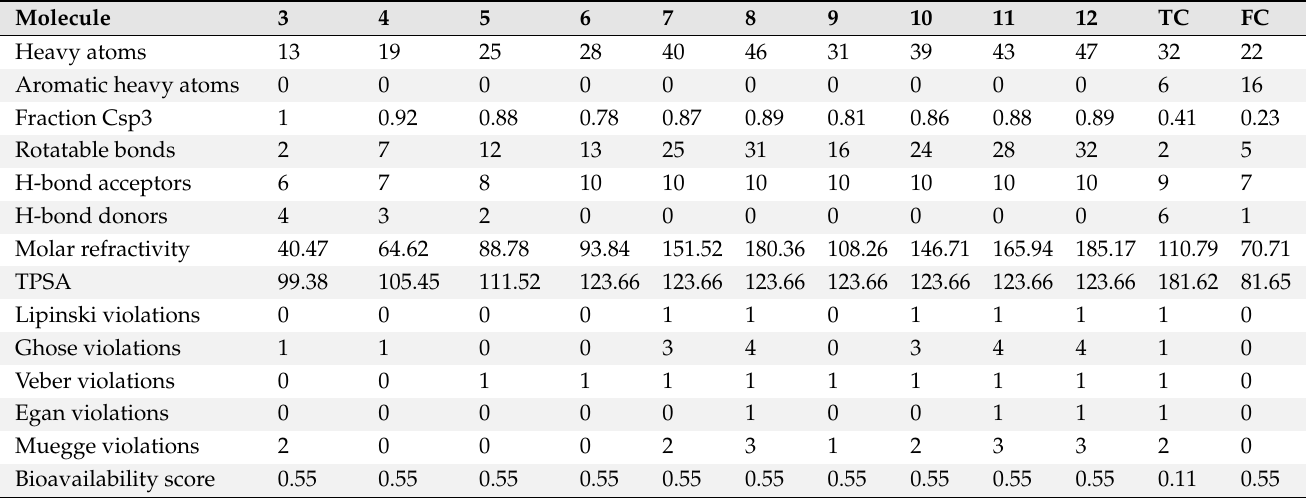
Table 9. Drug-likeness properties of galactopyranoside-derived synthesized